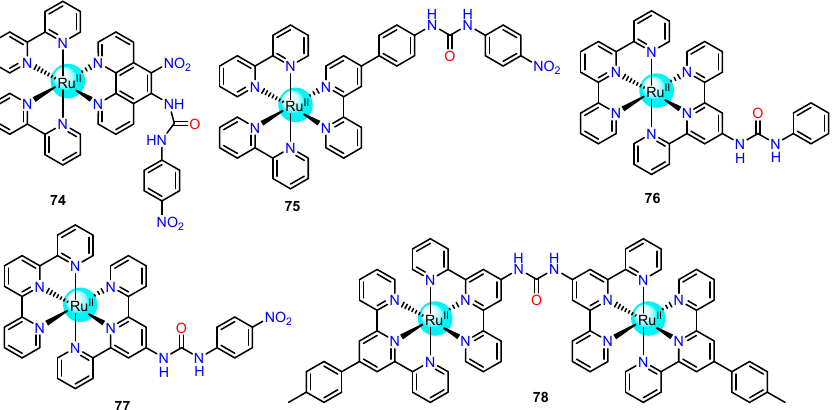
Figure 12. Structures of urea-based Ru(II) complexes 74 – 78 .